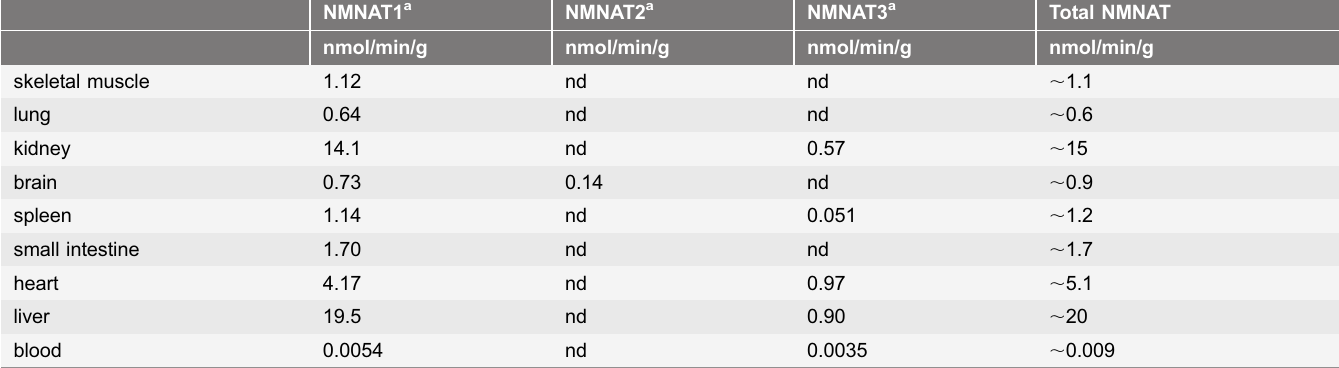
Table 2. Amidated route: estimates of NMNAT isozymes’ physiological activity.